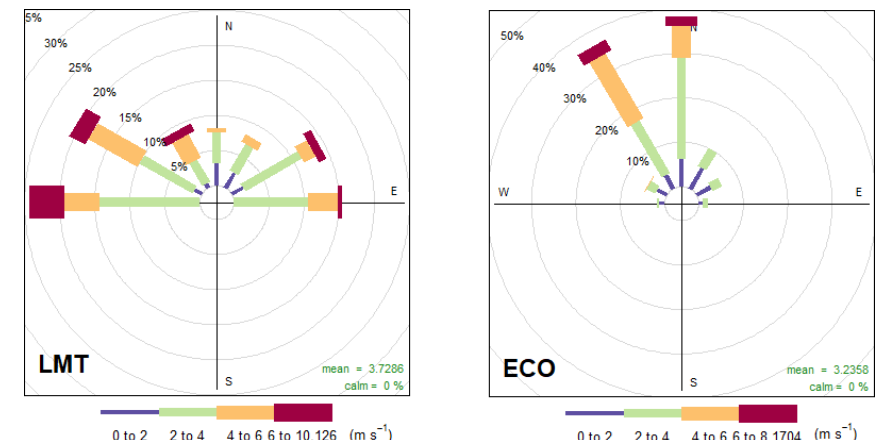
Figure 7. Wind roses related to event days for LMT and ECO observatories.